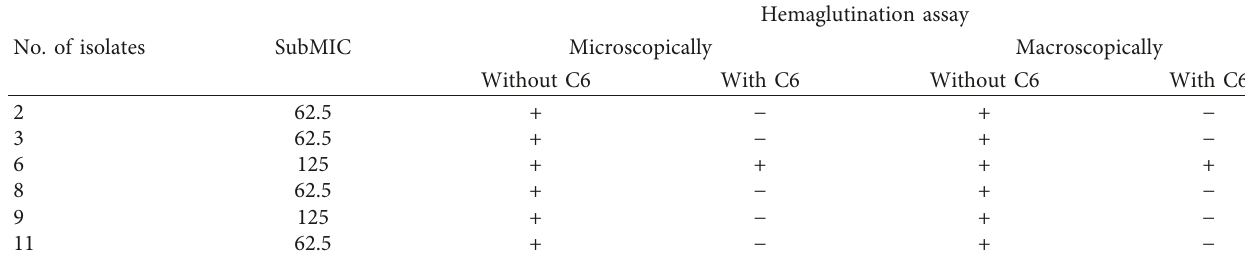
Hemaglutination assay Microscopically